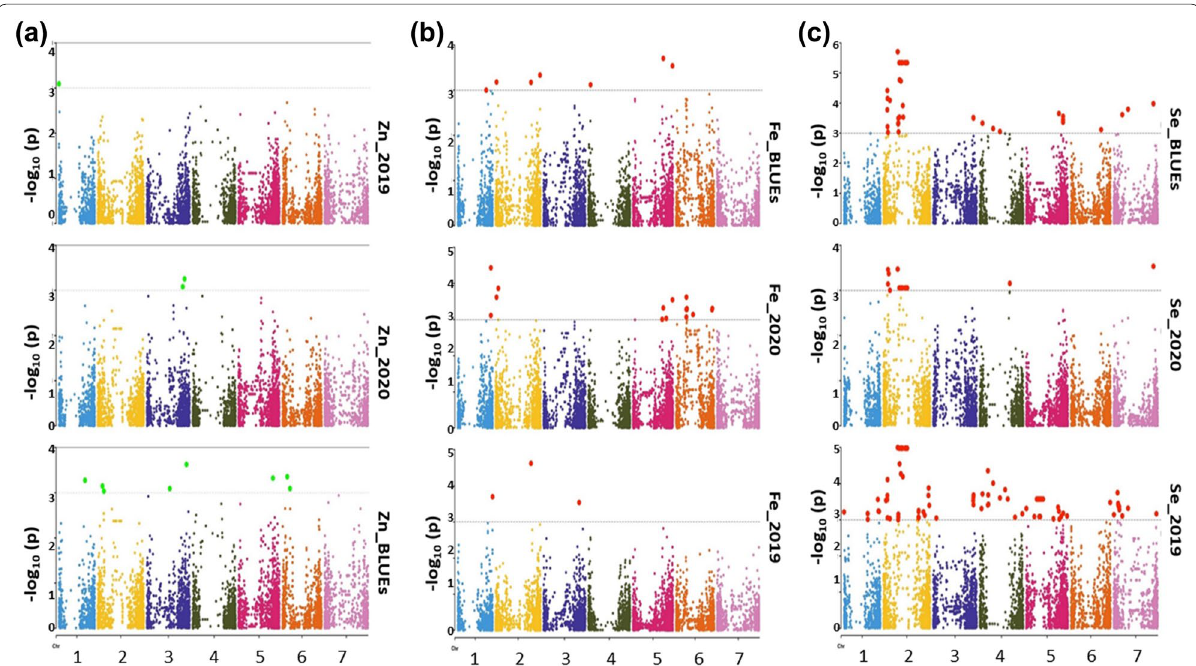
Fig. 6 Summary of genome‑wide association scans of Zn ( A ), Fe ( B ), and Se ( C ) for all barley genotypes (216) which were genotyped with a high‑density 9 K SNPs array from Illumina ™ for each year (2019/2020) and BLUEs. The horizontal red color line indicated the threshold of value) of